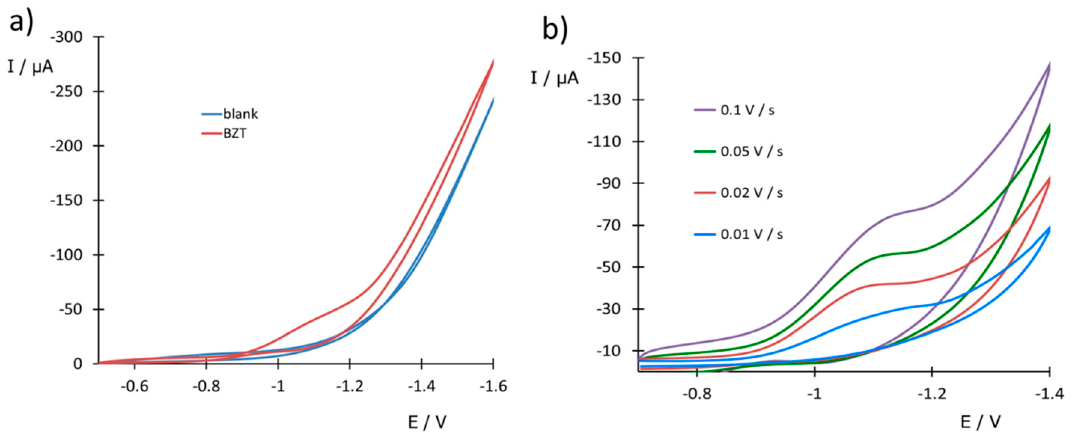
Figure 3. Cyclic voltammetry (CV) voltammograms measured with a SPCNFE in a solution containing 7 mg L -1 of BZT at pH 2.2, ( a ) at 0.01 V s -1 in comparison with the blank and ( b ) at different scan rates.